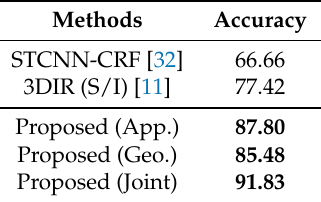
Table 8. The performance comparison of the recognition accuracy in the FERA dataset (%).